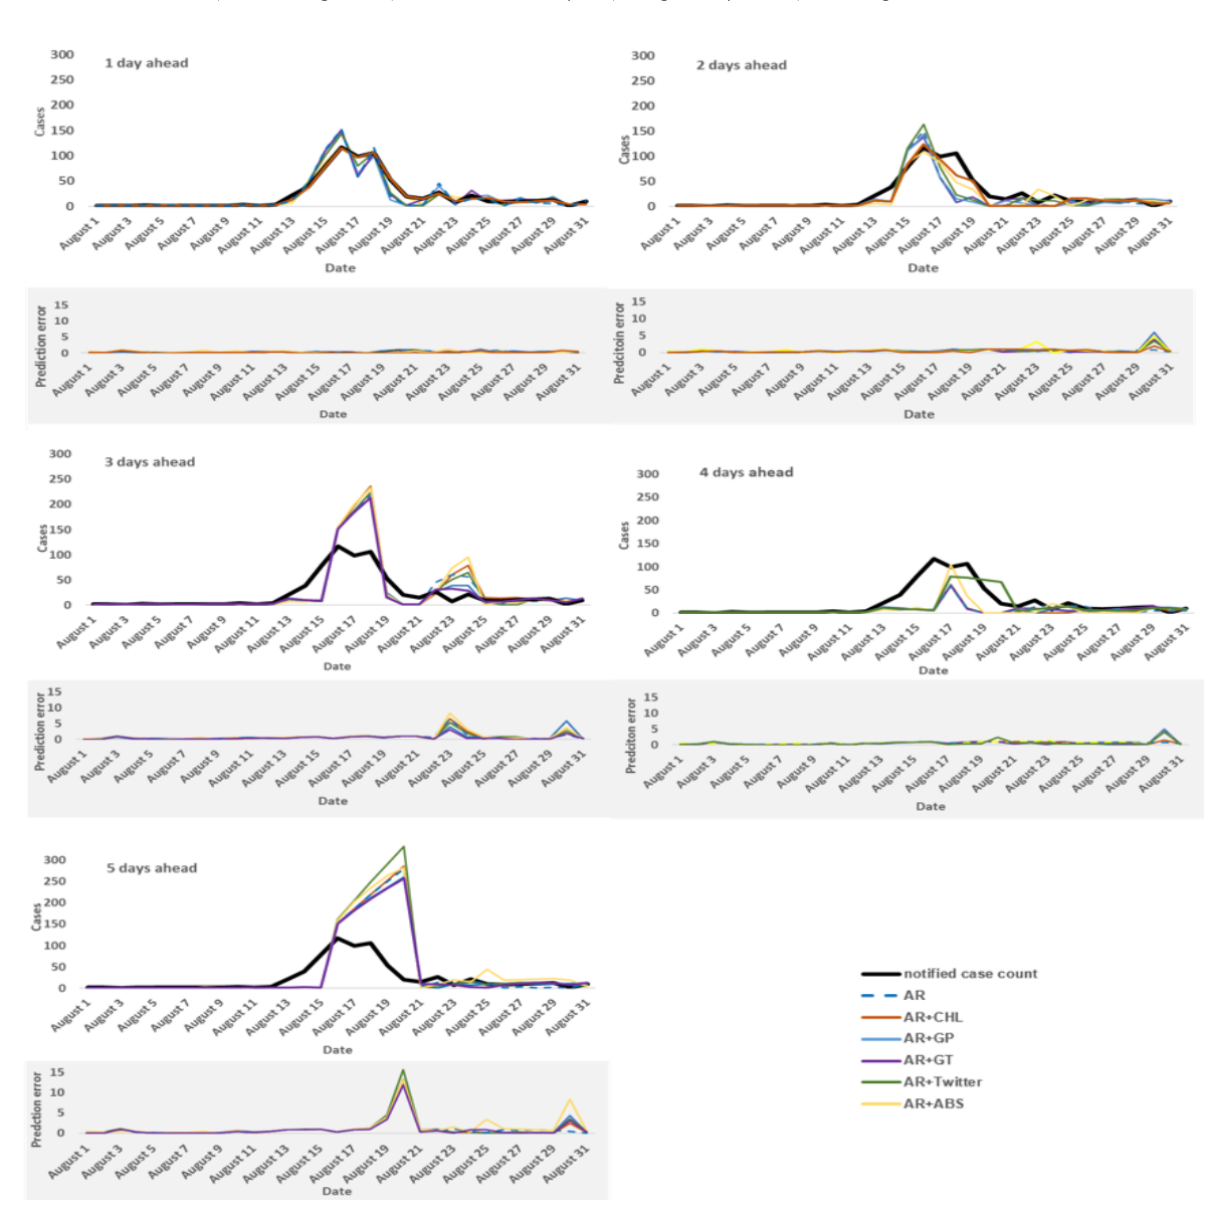
Figure 1. Actual notified case counts and prediction results 1 to 5 days ahead for all developed models, with their prediction errors based on relative root mean square error. The best model performance with the lowest prediction error (relative root mean square error) in each time series is shown as a bold line. ABS: abseentism; AR: autoregressive; CHL: consumer helpline; GP: general practice; GT: Google Trends.